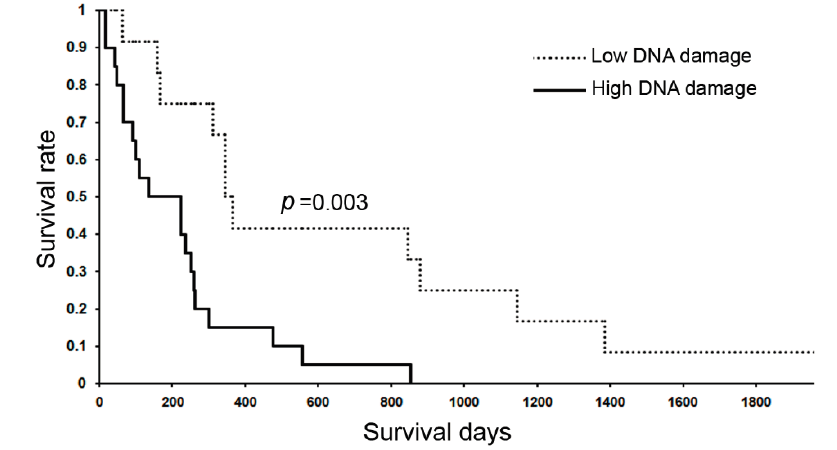
Figure 3. Kaplan-Meier analyses of 32 liver fluke-associated cholangiocarcinoma patients between high and low DNA damage formations in their tumor tissues. The levels of DNA damage were assessed by the double immunofluorescence method [107]. High